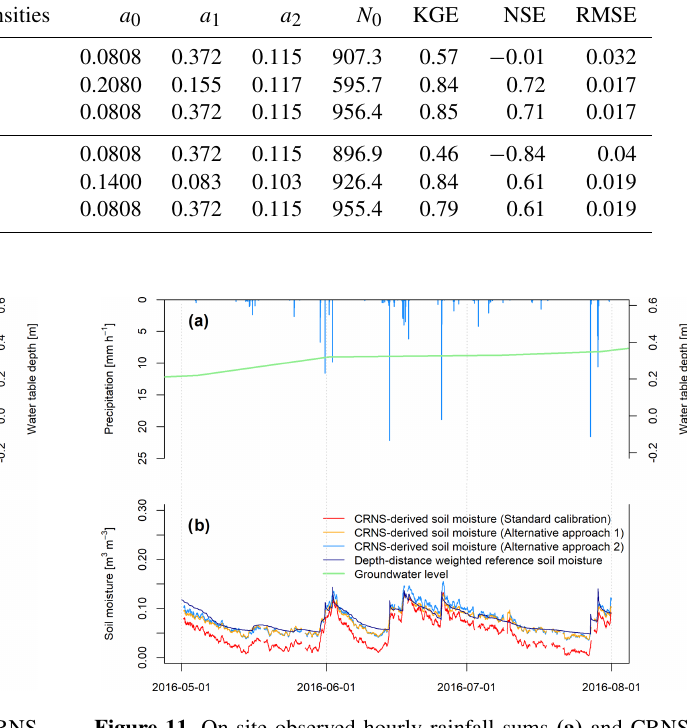
Figure 10. On-site observed hourly rainfall sums (a) and CRNS- derived soil moisture time series based on the standard calibration approach, as well as calibration approaches 1 and 2, in comparison to the depth–distance weighted reference soil moisture time series derived from SMT-100 sensors (b) .